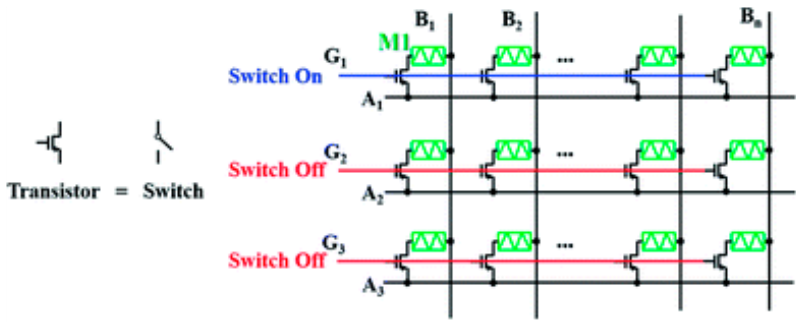
Figure 17. A schematic diagram of a one transistor–one memristor (1T1M) crossbar.